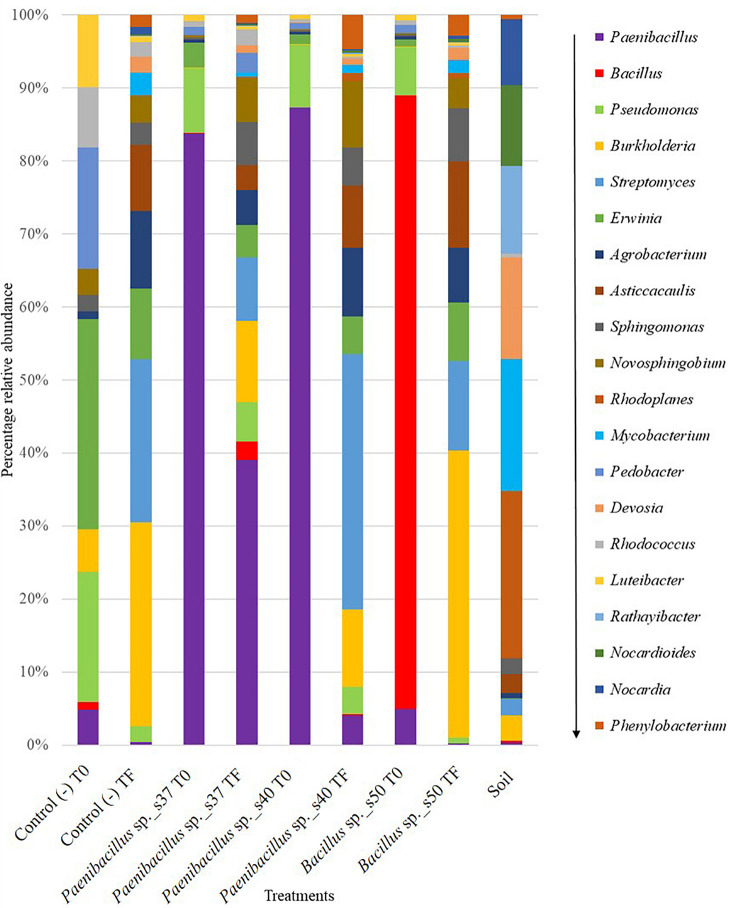
Stacked bar plot showing the relative abundance of bacterial OTUs classified to the genus level (only top 20 genera with the highest relative abundance are shown) in all treatments before (T0 = the seed at inoculation) and after (TF = the roots after 30 days) the greenhouse growth period. Data are based on the 16S rRNA amplicon sequencing of three biological replicates per sample. The panel at the right shows the bacterial genera in descending order from the genus with the highest relative abundance to the genus with lower relative abundances across all samples.